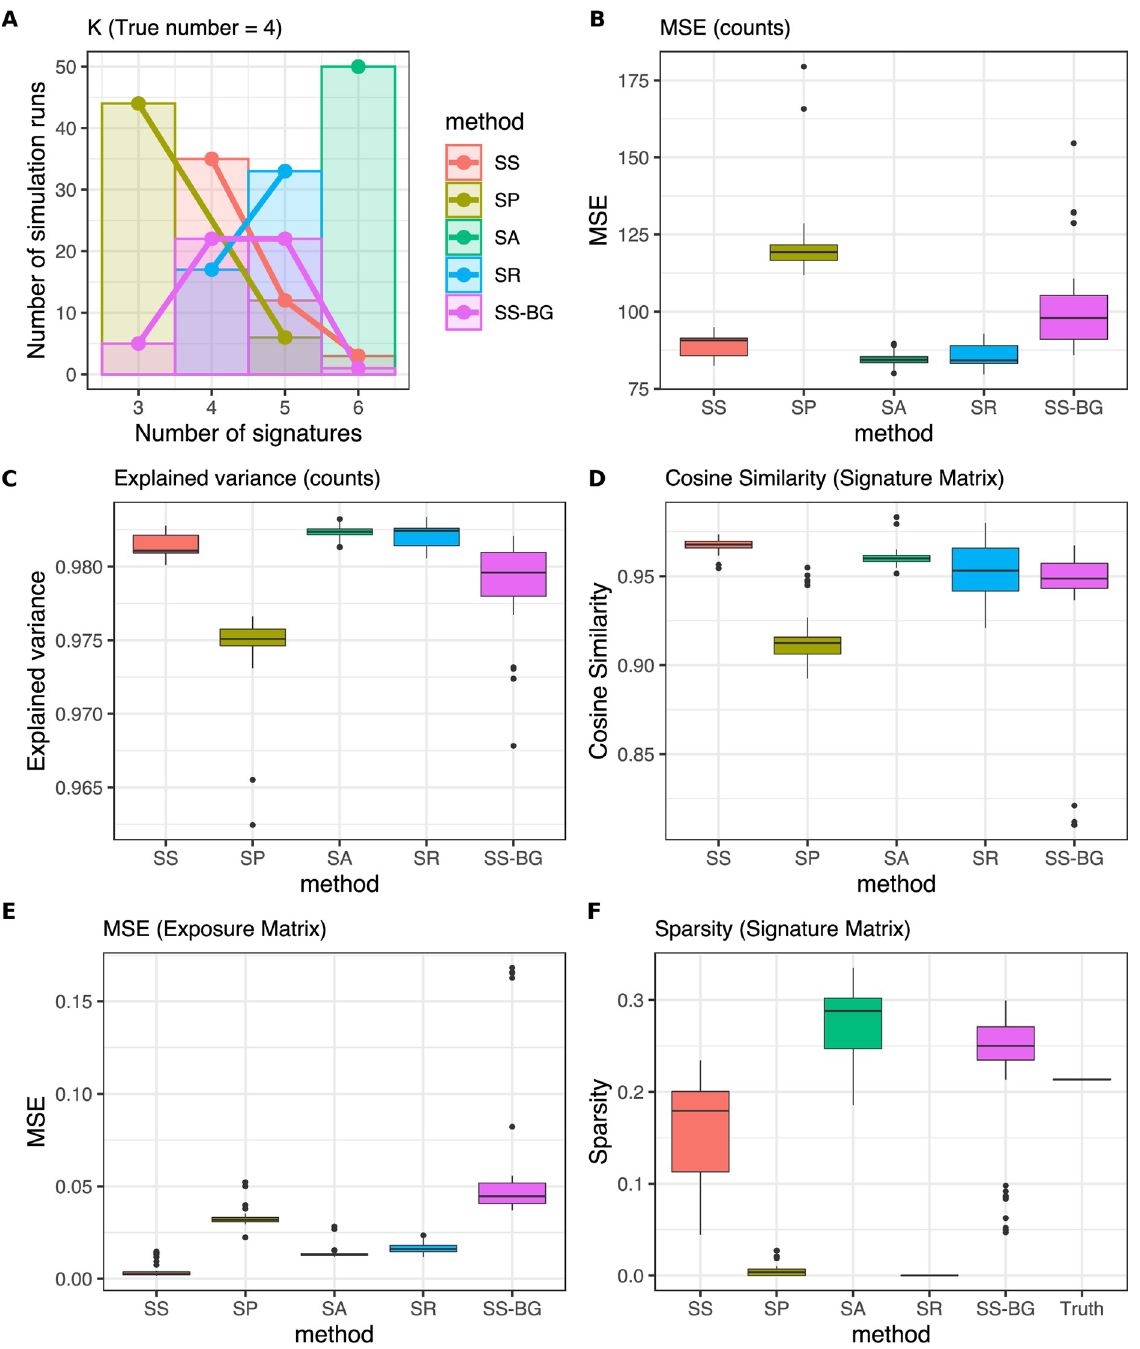
Fig 2. Comparison between SparseSignatures and other methods on simulated data. A) Bar and line plot showing, for each method, the number of simulations in which it selected each value of K (number of signatures). The x-axis shows values of K and the y-axis shows the number of times each value was selected. Each method was run on 50 simulated datasets. In all cases, the correct value of K was 4. B) Box plots showing the residual error for the solutions produced by each method, over 50 simulations. Residual error was measured as the mean squared error (MSE) in reconstructing the original count matrix. C) Box plots showing the fraction of variance in the count matrix explained by the solutions produced by each method, over 50 simulations. D) Box plots showing the cosine similarity in reconstructing the 3 non-background input signatures, over 50 simulations. E) Box plots showing the mean squared error in reconstructing the exposure values for the 3 non- background input signatures, over 50 simulations. F) Box plots showing the sparsity of the signatures produced by each method, over 50 simulations. Sparsity was measured as the fraction of cells in the signature matrix whose value is < 10 − 3 . SS: SparseSignatures. SP: SigProfiler. SA: SignatureAnalyzer. SR: signeR. SS-BG: SparseSignatures without fixed background. Source data are provided in S2 Table.